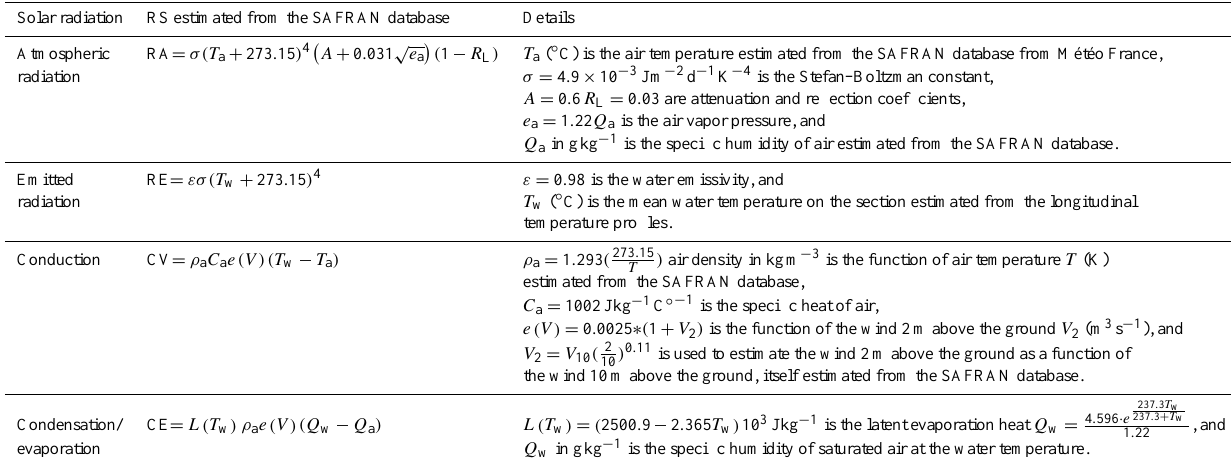
Table 2. Details of the atmospheric heat flux calculations. Solar radiation RS estimated from the SAFRAN database